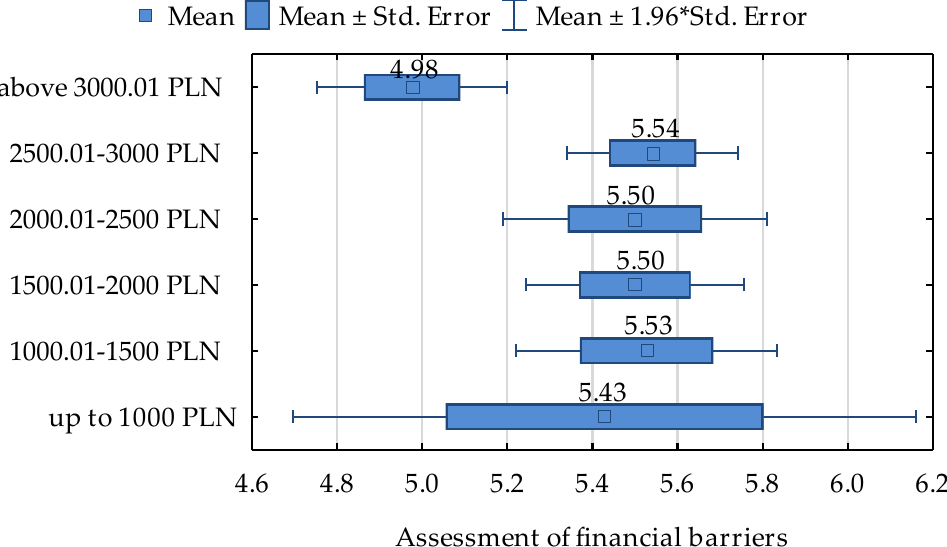
Figure 8. Assessment of financial barriers according to disposable income. Source: own study N = 387.